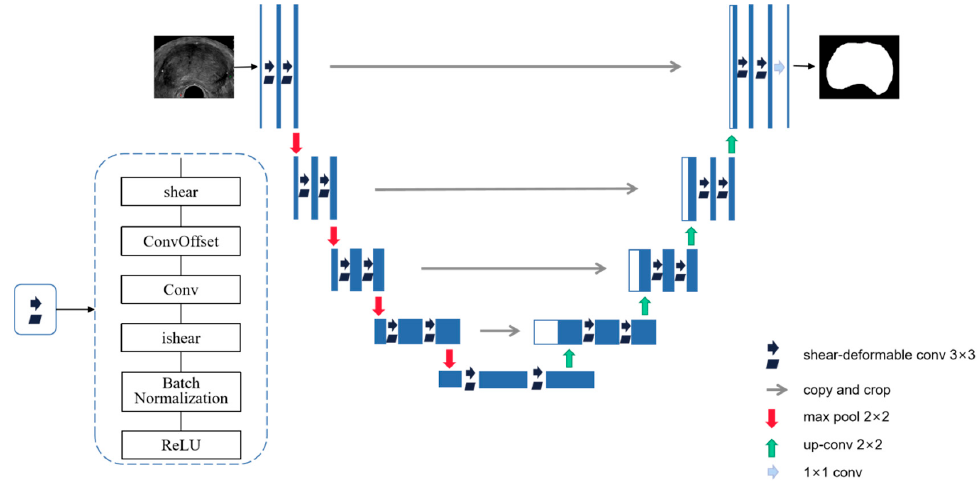
Figure 5. Structure diagram of prostate segmentation network model based on DSU-Net. Figure 5. structure diagram of prostate segmentation network model based on DSU-Net.